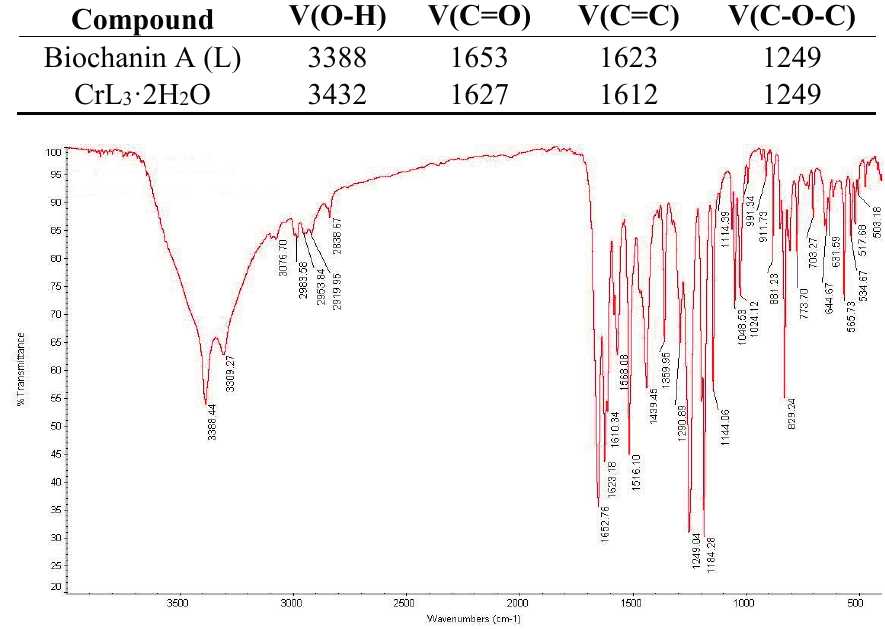
Table 3. The primary IR spectral data of genistein and the chromium complexes (cm − 1